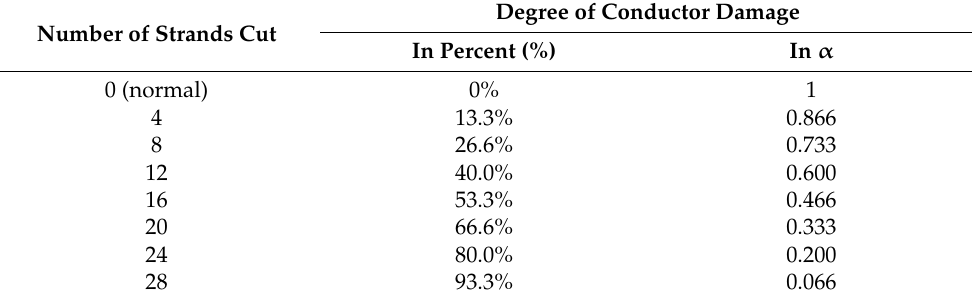
Table 1. Degree of damage